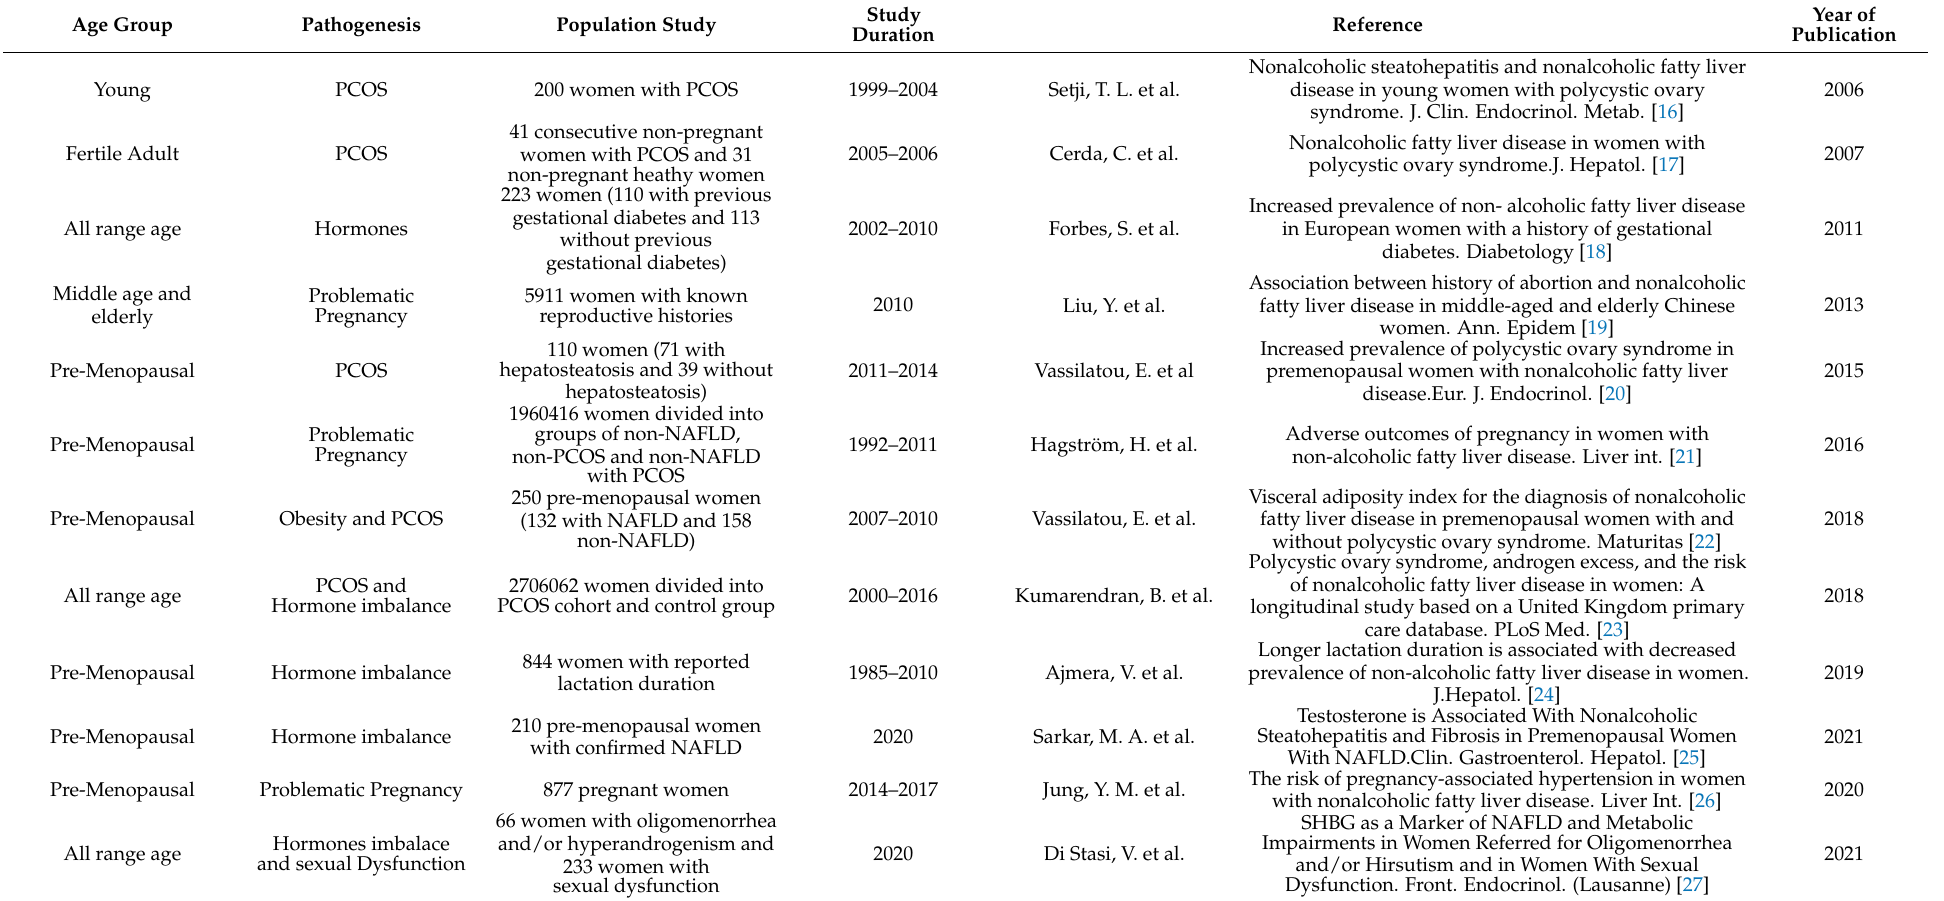
Table 1. List of the studies considered for the systematic study. These studies included patient age range and